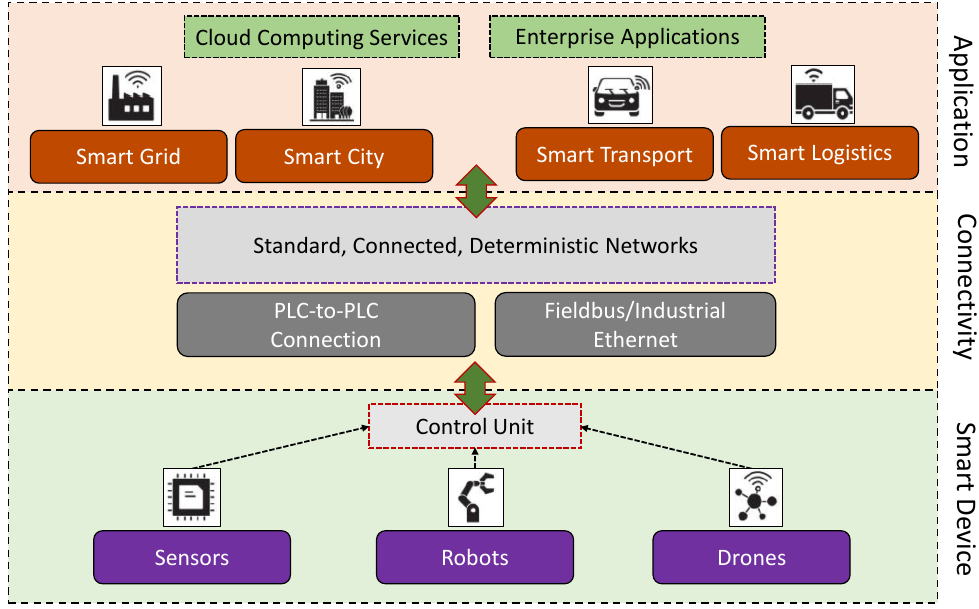
Figure 2. A simple outline of the basic concept of an IIoT